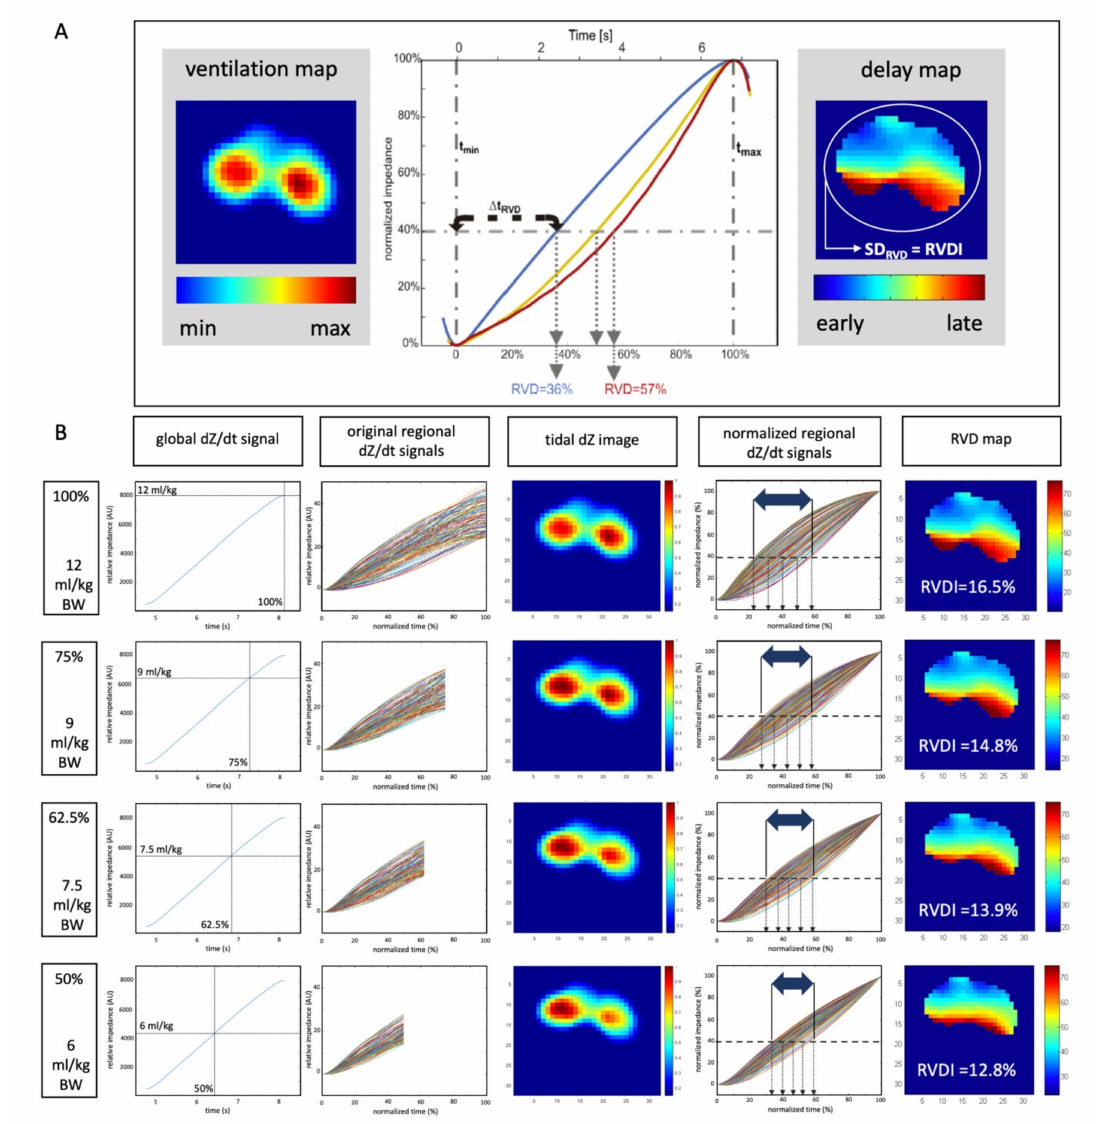
Figure 1. ( A ) Left ventilation map (tidal dZ image) from a slow inflation; middle: Normalized regional impedance / time curves of three exemplary pixels, blue: Early aerated, yellow: Delayed aeration, red: Very late aeration. Regional-Ventilation-Delay time ( ∆ t RVD ) as the di ff erence between the start of inspiration and the time when the respective regional curve ∆ Z i (t) reaches a threshold of 40% of the maximal local impedance change. RVD = ∆ t RVD / ∆ t max − min; right: Delay map: Color coding of pixel-wise regional-ventilation-delay (RVD) indices; Regional ventilation delay inhomogeneity (RVDI): Quantification of temporal heterogeneity (regional ventilation delay inhomogeneity). ( B ) Schematic description; calculation of RVD indices and RVDI from the original 12 mL / kg inflation (analyses from 100% inflation time) and simulation of inflations of reduced inflation volumes of 9, 7.5, and 6 mL / kg (analyses from electrical impedance tomography (EIT) signals truncated after 75%, 62.5%, and 50% inflation time). Images show global dZ / dt curves, original regional dZ / dt curves, tidal dZ images (ventilation map), normalized regional dZ / dt curves for RVD analyses, RVD maps (scaled in % inflation time) and resulting RVDI